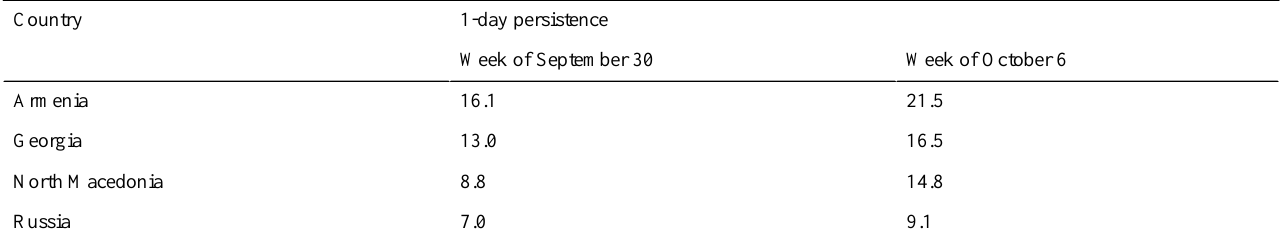
Table 6. Comparison of 1-day persistence in the four countries in Central Asia with positive significant positive accelerations for the week of October